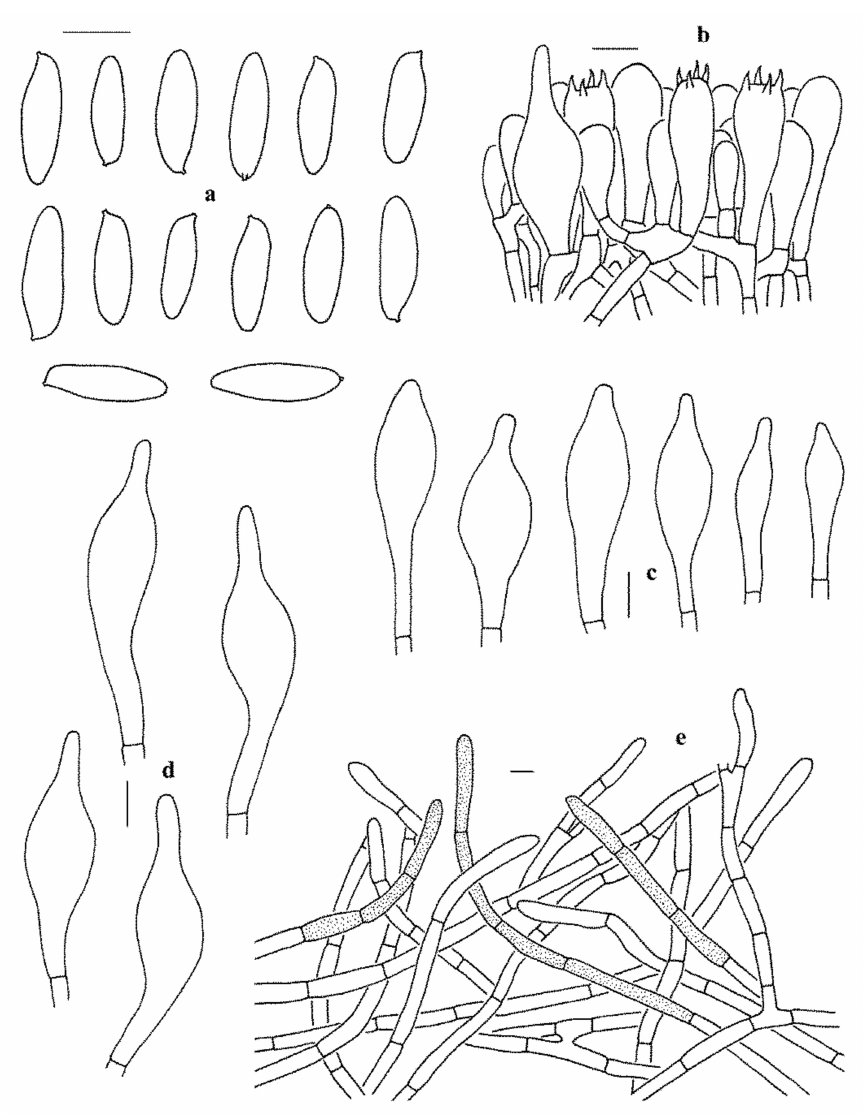
Figure 5. Microscopic features of Leccinum parascabrum (KUN-HKAS99903, holotype). ( a ) Basid- iospores. ( b ) Basidia and pleurocystidium. ( c ) Cheilocystidia. ( d ) Pleurocystidia. ( e ) Pileipellis. Bars = 10 µ m. Drawings by Y.-C.